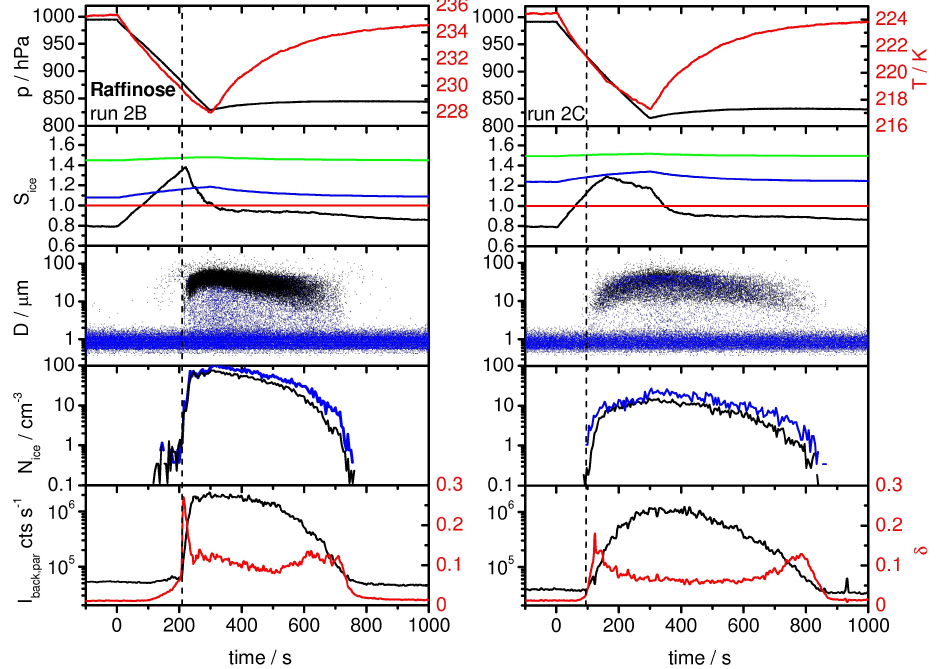
Fig. 8. Time series of various AIDA records during expansion runs 2B and 2C with raffinose. The individual panels contain the same measurements as in Fig.